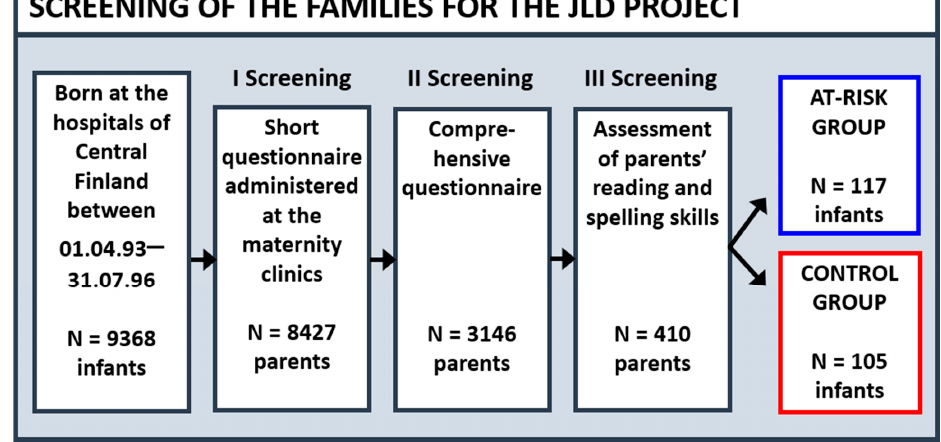
Figure 1. Screening of the families for the Jyväskylä Longitudinal Study of Dyslexia.